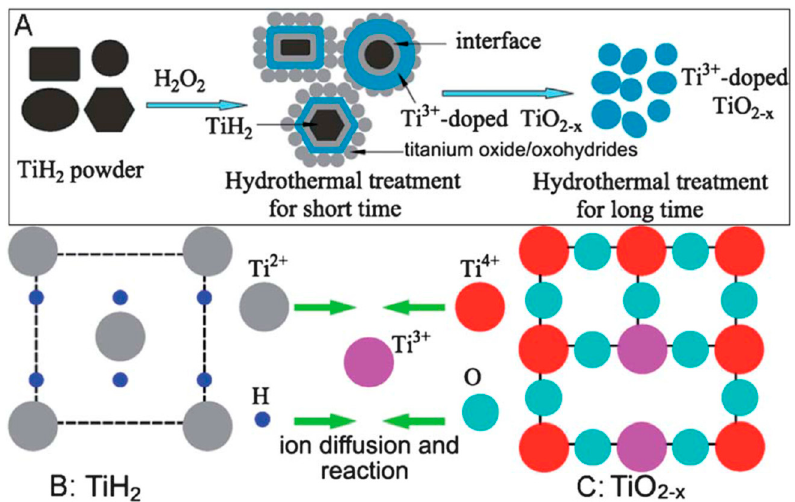
Figure 8. ( A ) Schematic of the formation mechanisms for the rice-shaped Ti 3+ self-doped TiO 2 − x nanoparticles. ( B , C ) The interface diffusion–redox diagram. The green arrows indicate ion diffusion [62]. Copyrighted 2014 The Royal Society of Chemistry.